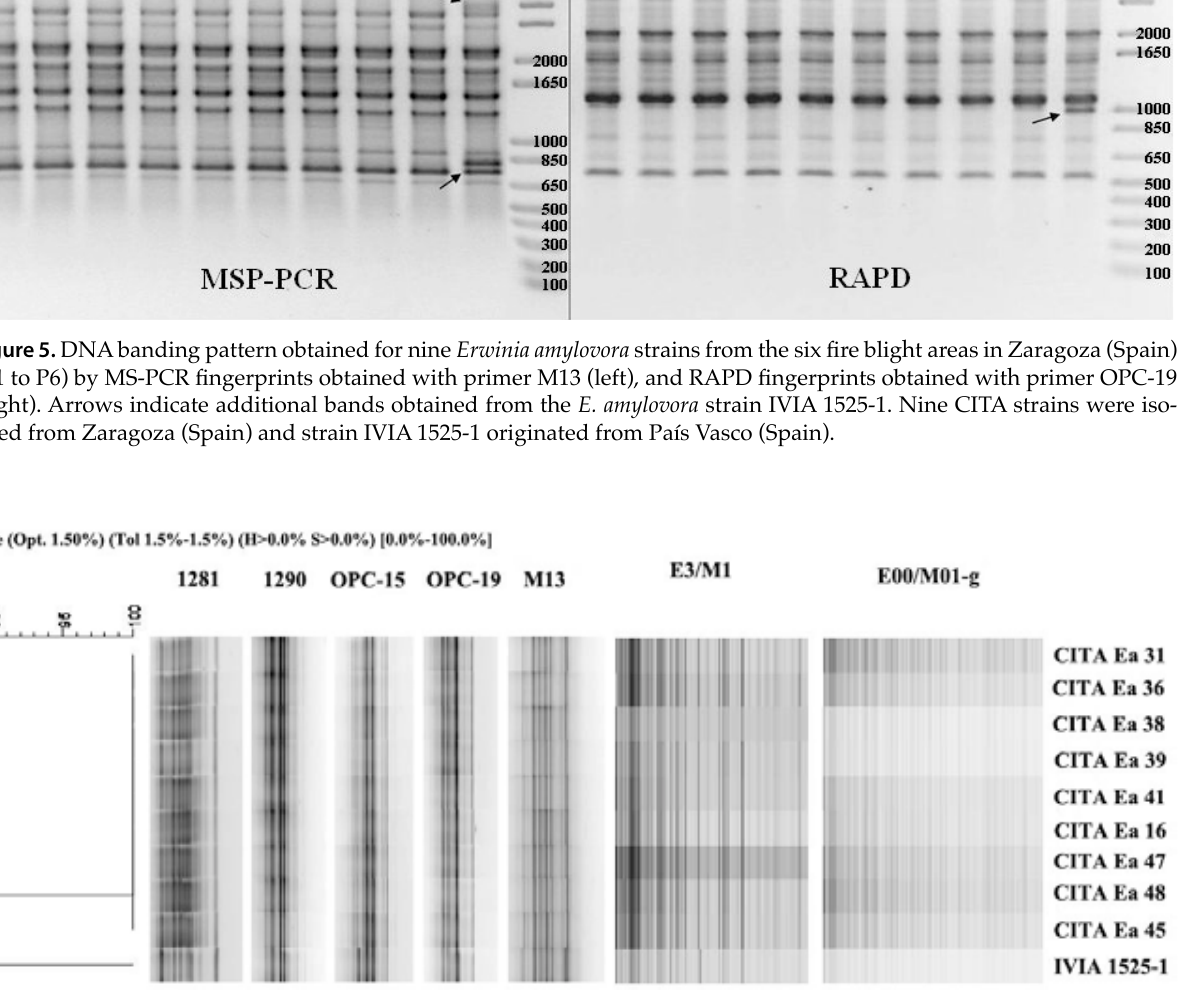
Figure 6. Combined dendrogram of the RAPD analyses (primers 1281, 1290, OPC-15 and OPC-19), MS-PCR (primer M13) and AFLP (E3/M1 and E00/M01-g primers pairs) applied to nine Erwinia amylovora Aragón strains. Nine CITA strains were isolated from Zaragoza (Spain) and strain IVIA 1525-1 originated from another Spanish